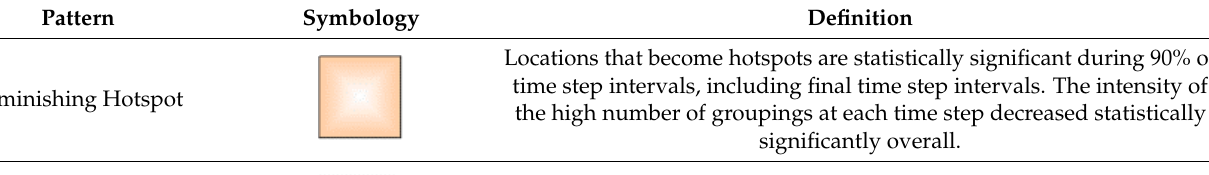
Table A2. Cold spot categories based on [44].